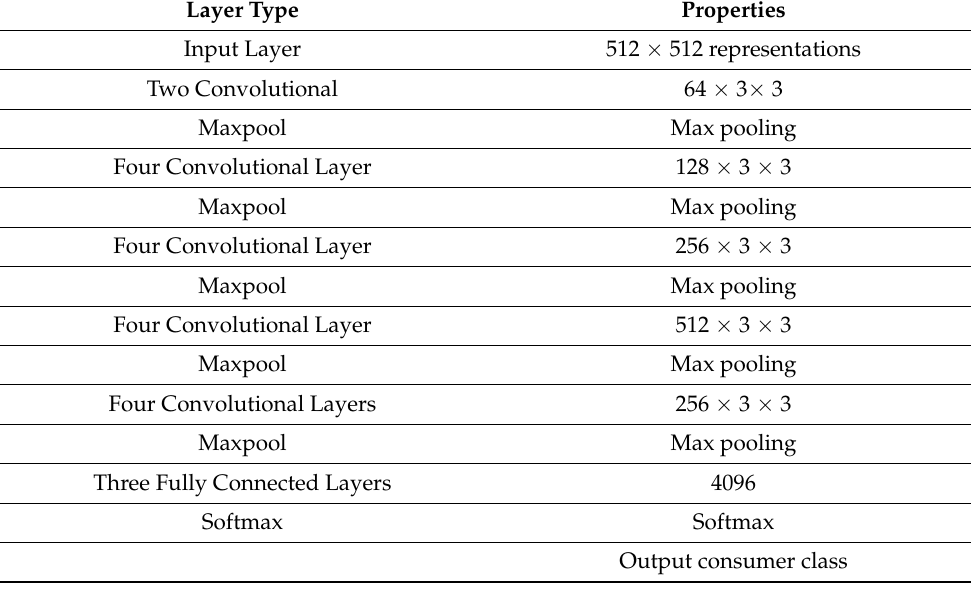
Table 1. The description of Vgg19 network [33].